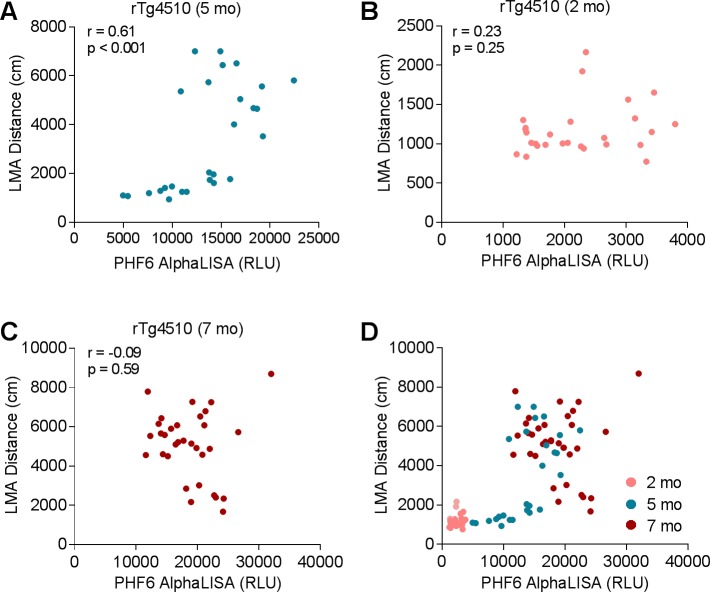
Correlation between LMA and brain hyperphosphorylated tau levels.(A) LMA positively correlated with brain hyperphosphorylated tau detected by PHF6 alphaLISA in 5-month-old rTg4510 mice (r = 0.61, p < 0.001, n = 27). (B–C) Lack of correlation between LMA and brain hyperphosphorylated tau in rTg4510 mice at 2 months of age (B, r = 0.23, p = 0.25, n = 30) and 7 months of age (C, r = -0.09, p = 0.59, n = 36). (D) Plot of LMA distance as a function of brain hyperphosphorylated tau levels at 2, 5, and 7 months of age.